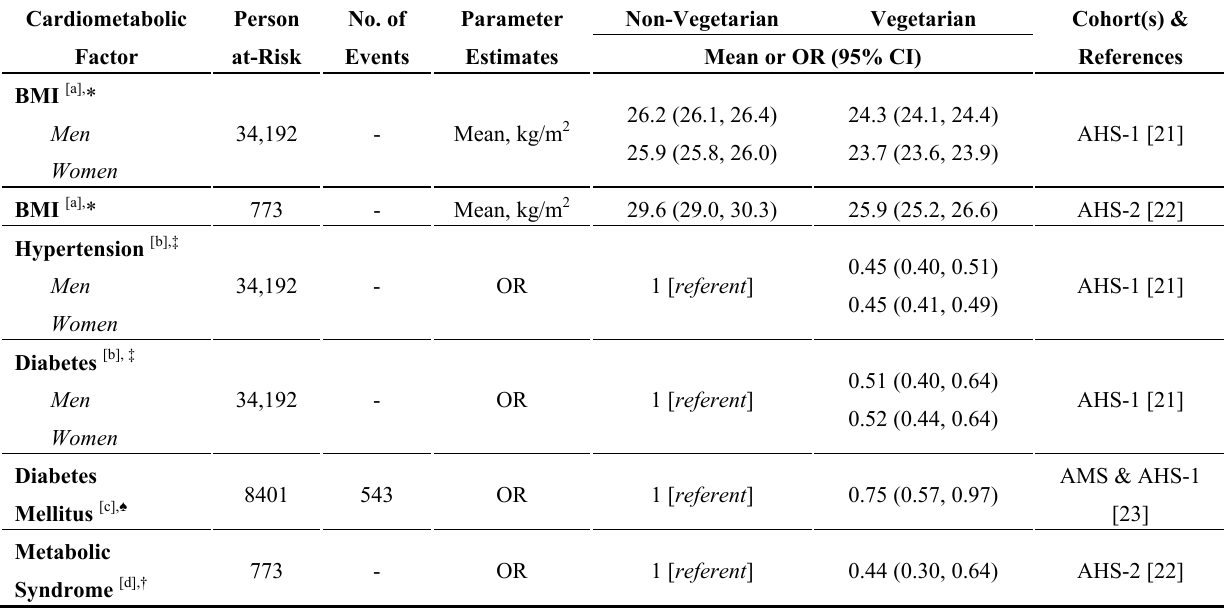
Table 3. Cardiometabolic factors among vegetarian and non-vegetarian Adventists.